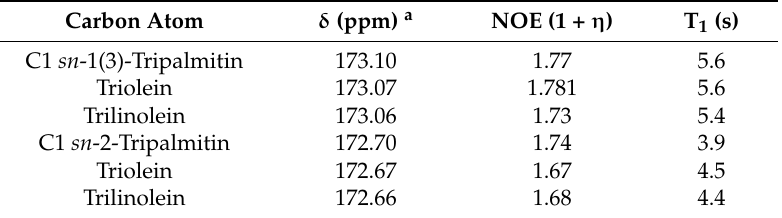
Table 12. NOE and T 1 values of carbonyl carbons of triglycerides. Reprinted, with permission, from [20]. Copyright 1999, Elsevier Science B.V.